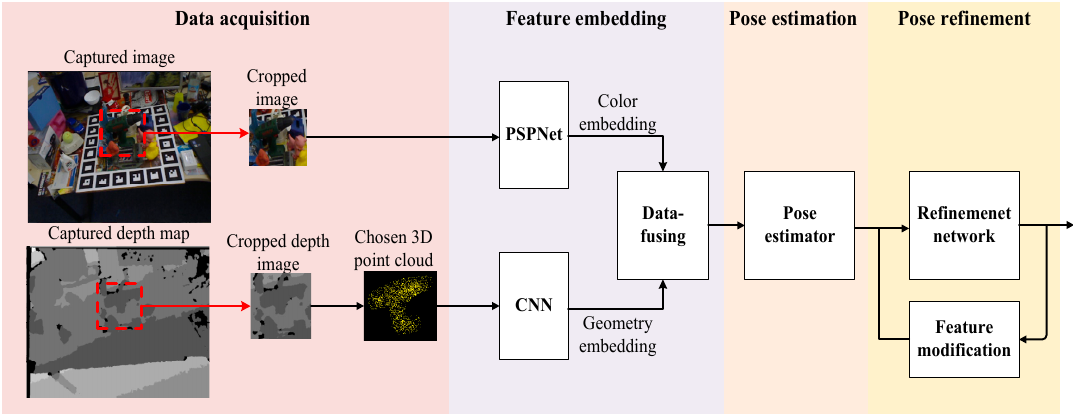
Figure 1. The architecture of the proposed pose estimation system.